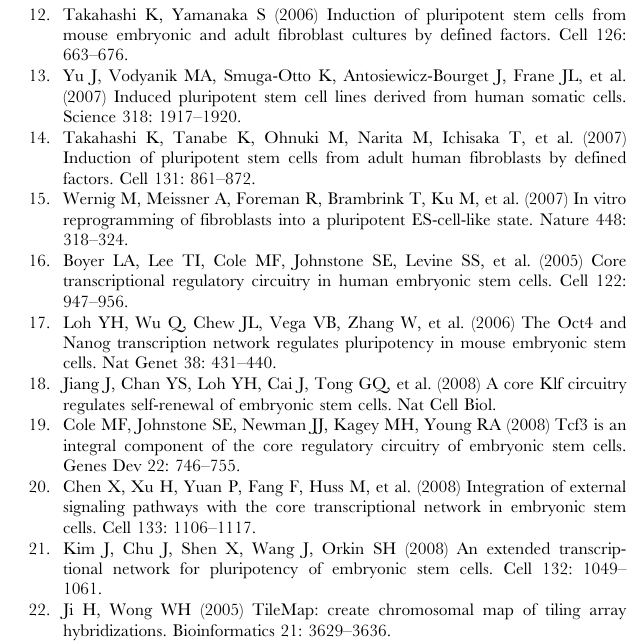
Table S3 Stat3 and c-Myc occupied genes co-bound with Oct4 and